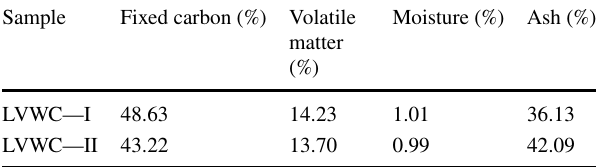
Table 1 Proximate analysis of LVWC (air dried basis)